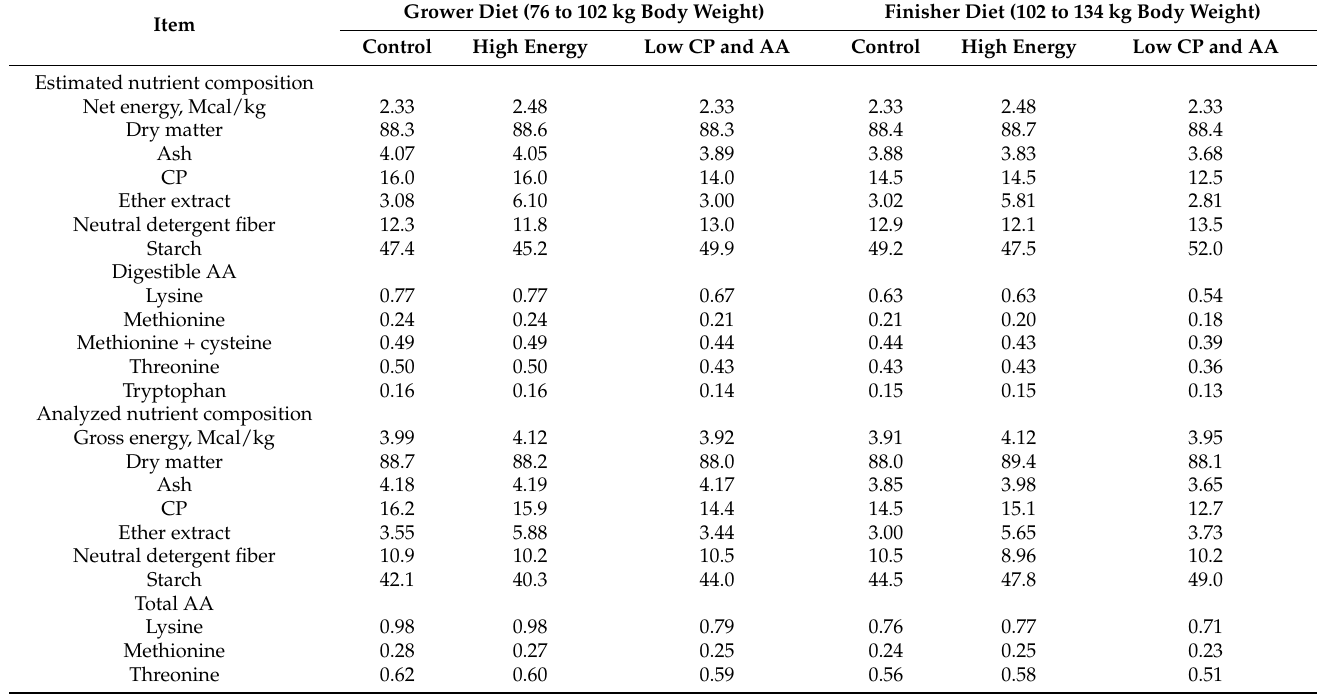
Table 1. Estimated and analyzed nutrient composition of the experimental diets (%, as-fed basis).